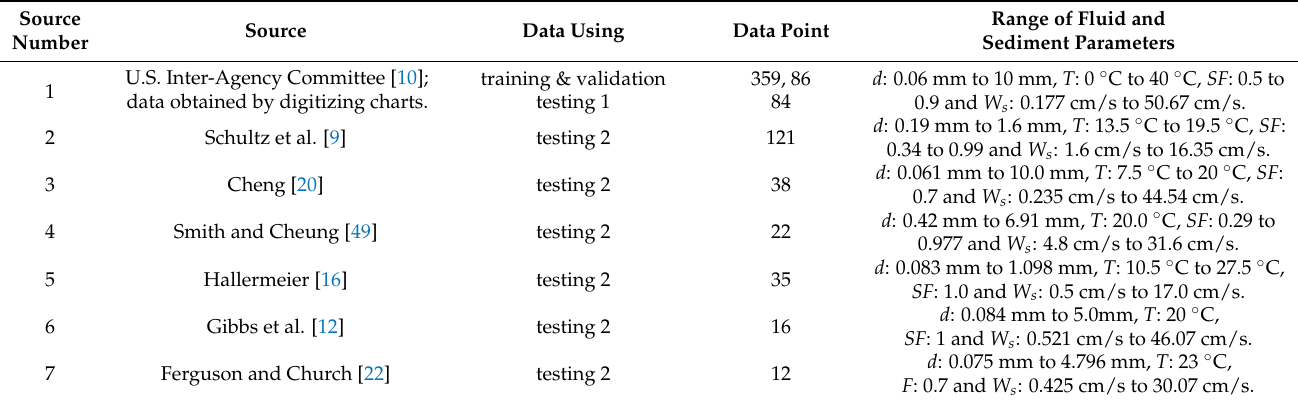
Table 1. Data used for training, validation, and testing ANN